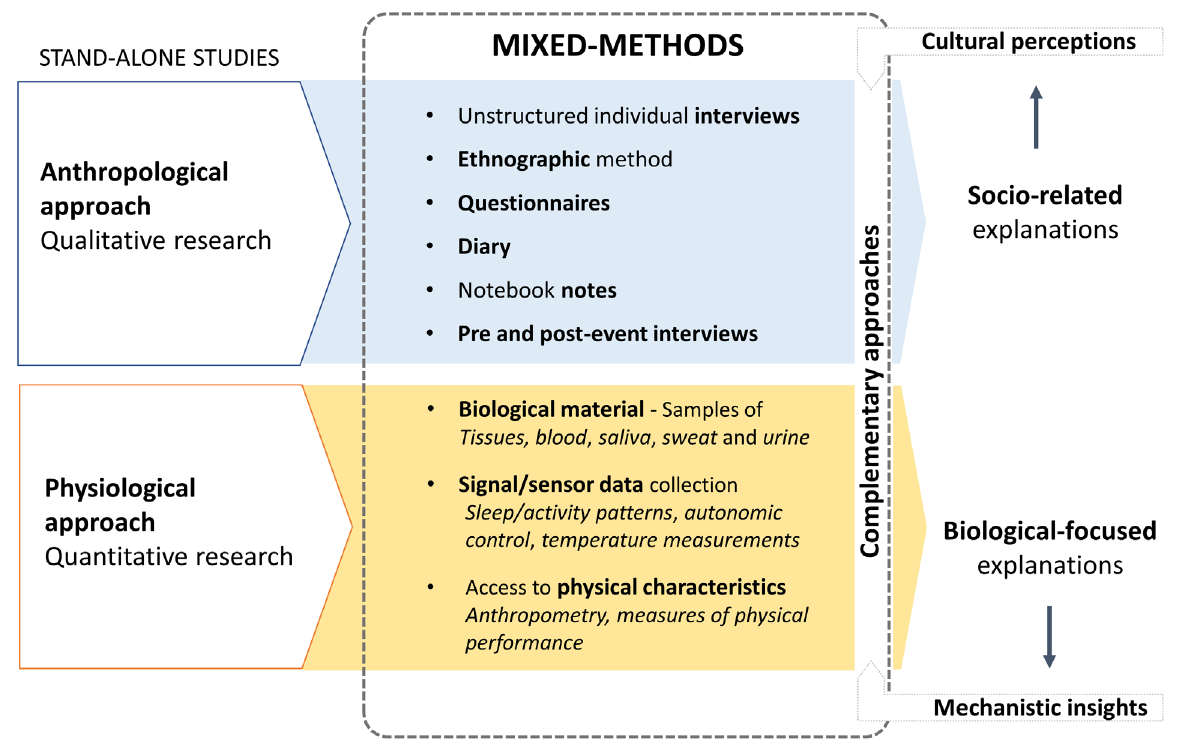
Figure 2. Perspectives on the interaction and insights for mixed-methods of human-related research activities in Antarctica. The anthropological/qualitative views and the physiology/quantitative views methods present their field research tools that result, respectively, in socio-related and biological-focused explanations. Explanations from the methods of anthropology allow for cultural insights, while explanations from the methods of physiology allow for mechanistic insights; collectively, these responses are complementary approaches that contribute to understanding the same research problem, which is the human presence in